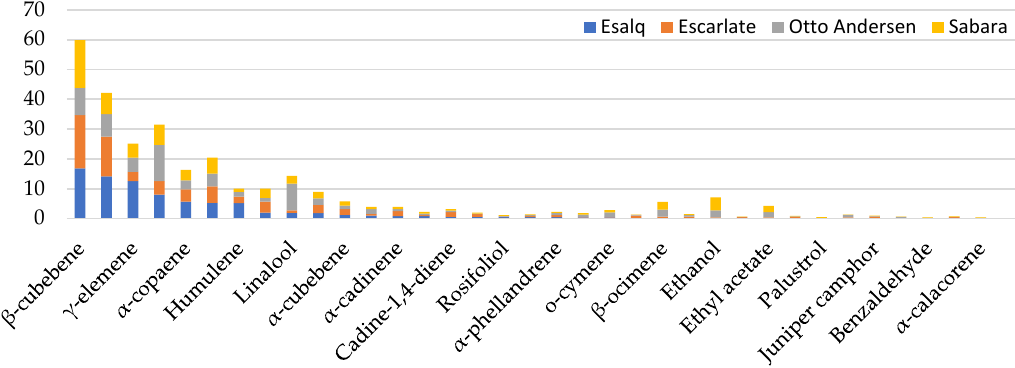
Figure 2. Percentage of the relative area of the 36 volatile organic compounds in relation to all compounds identified in ‘Sabará’ ( Plinia jaboticaba ), ‘Escarlate’ ( Plinia phitrantha × Plinia cauliflora) , ‘Otto Andersen’ ( Plinia cauliflora ), and ‘Esalq’ ( Plinia phitrantha ) jabuticabas.